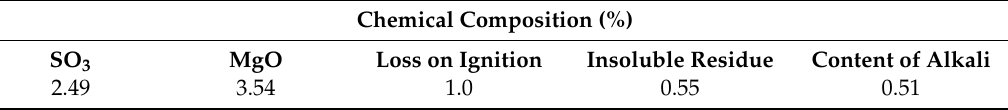
Table 3. Chemical composition of cement.